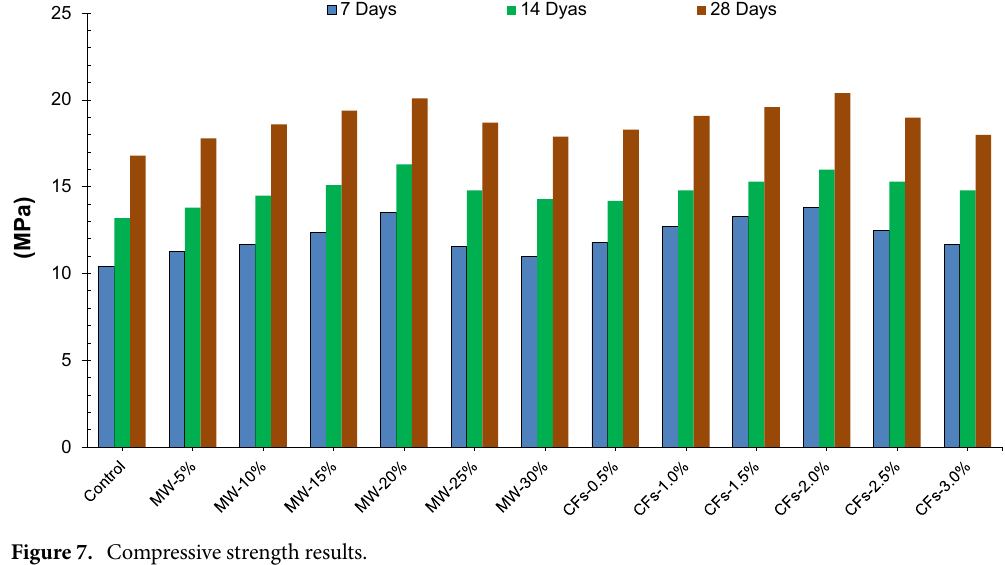
Figure 7. Compressive strength